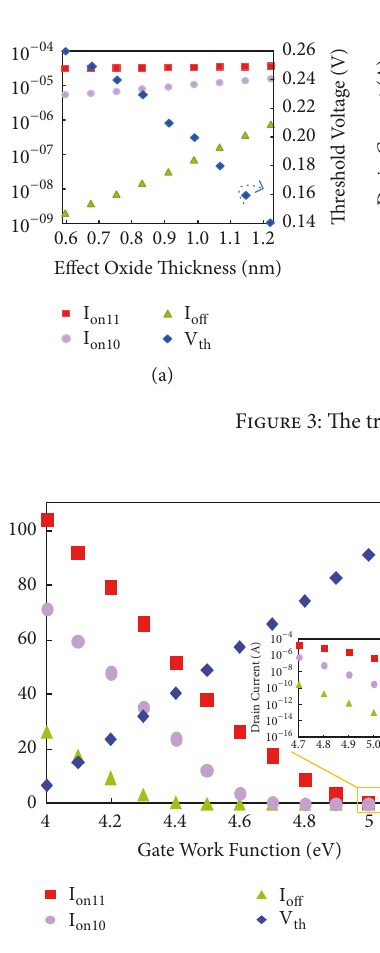
Figure 4: The trend of the drain current versus gate work function.